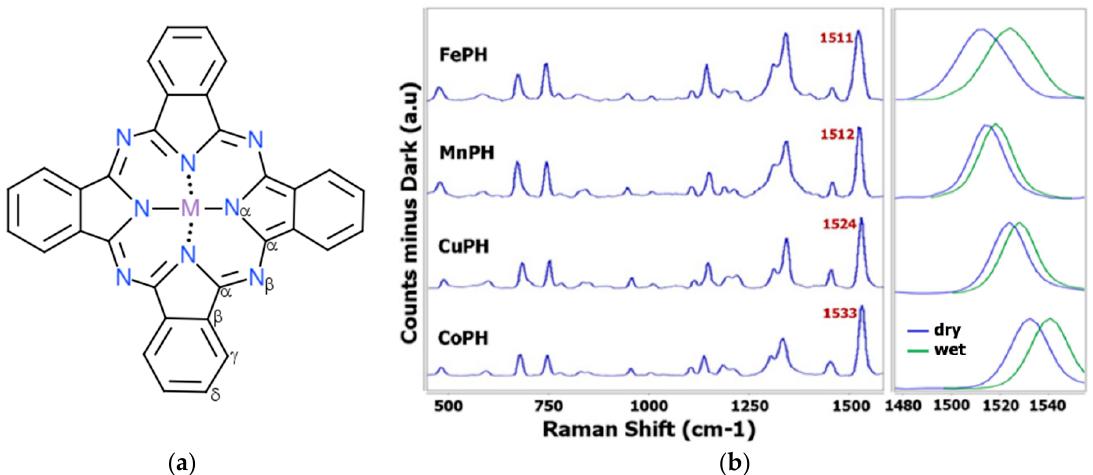
Figure 1. ( a ) Chemical structure of metal phthalocyanines. M = Co, Cu, Mn and Fe. ( b ) Raman spectra of dry (blue line) and wet (green line) CoPH (DRP ‐ 410), CuPH (DRP ‐ 110CUPH), MnPH (DRP ‐ dry (blue line) and wet (green line) CoPH (DRP-410), CuPH (DRP-110CUPH), MnPH (DRP-110MNPH) 110MNPH) and FePH (DRP ‐ 110FEPH). Spectra were recorded using 10 s as the integration time and and FePH (DRP-110FEPH). Spectra were recorded using 10 s as the integration time and corrected by corrected by baseline subtraction. baseline